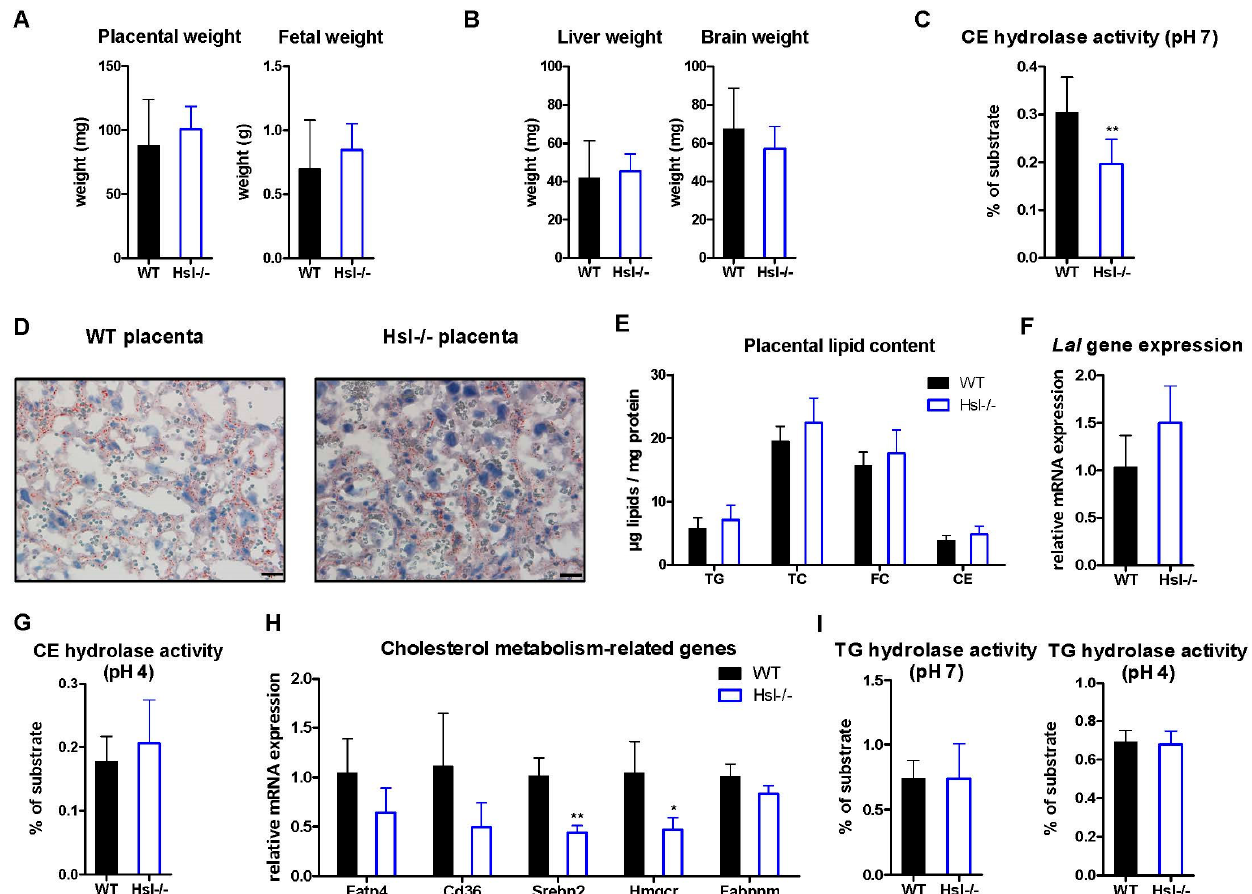
Figure 2. Hormone-sensitive lipase (HSL) deficiency does neither affect mouse placental or fetal weight nor lipid content. Placentas were isolated from WT and Hsl-/- mice on day 19 of pregnancy. ( A ) Placental and fetal weight ( n = 36–41 WT, 24 Hsl-/-) as well as ( B ) fetal organ weights ( n = 18 WT, 22 Hsl-/-). ( C ) Neutral CE hydrolase activity in the placenta ( n = 10). ( D ) ORO staining of cryosections from placentas. Magnification, 40×; Scale bar, 20 µm. ( E ) Placental lipid concentrations ( n = 4). ( F ) Gene expression of placental Lal ( n = 4). ( G ) Acid CE hydrolase activity in the placenta ( n = 10). ( H ) mRNA expression of placental genes related to cholesterol metabolism. ( I ) Neutral and acid TG hydrolase activities in placentas ( n = 10). Data represent mean values + SD from different dams. Statistically significant differences were calculated by two-tailed Student’s t -test; * p < 0.05, ** p ≤ 0.01.